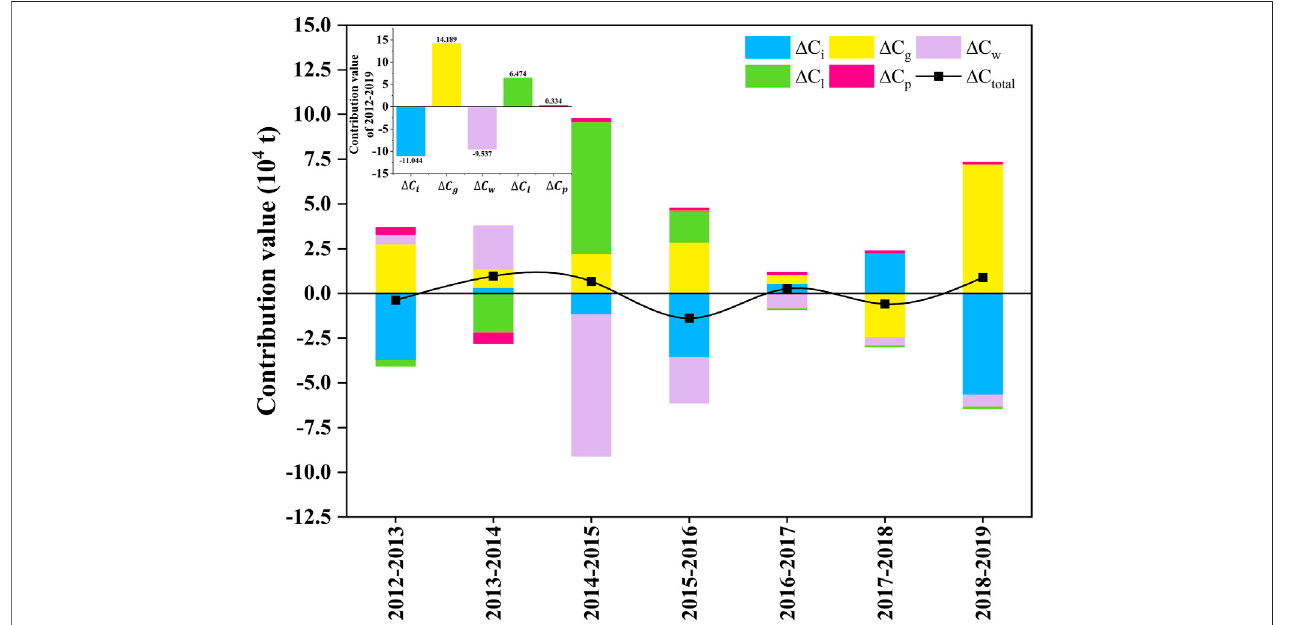
FIGURE 6 | Contributions of in fl uencing factors of agricultural carbon emissions in Zhangye during 2012 – 2019.